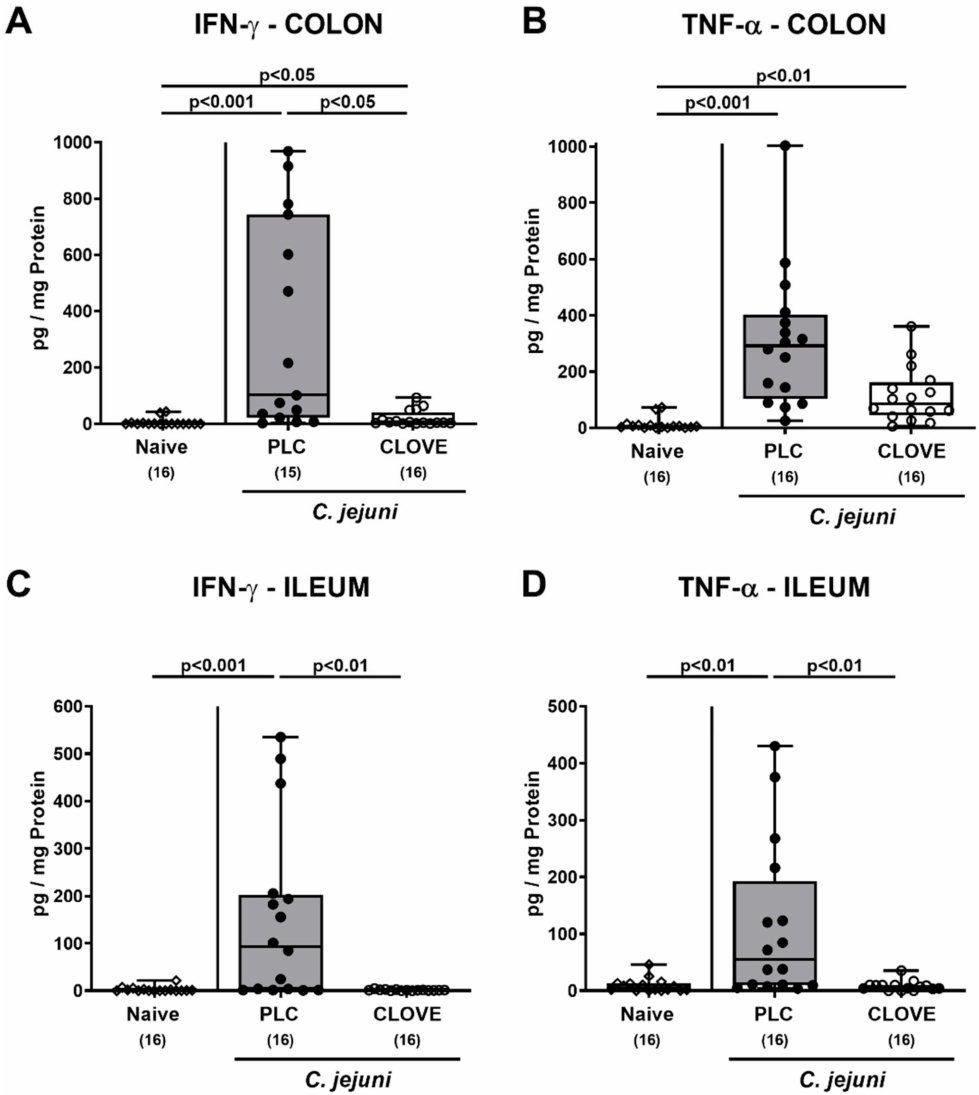
Figure 6. C. jejuni induced intestinal proinflammatory cytokine secretion following clove EO treat- ment of infected IL-10 − / − mice. Microbiota-depleted IL-10 − / − mice were perorally infected with C. jejuni strain 81-176 on day (d) 0 and d1. From d2 until d6 post-infection (p.i.), mice were perorally challenged with clove EO or received placebo (PLC) via drinking water. On day 6 p.i., ( A , C ) IFN- γ and ( B , D ) TNF- α concentrations were measured were measured in ex vivo biopsies derived from the ( A , B ) colon and ( C , D ) ileum. Box plots indicate the 75th and the 25th percentiles of the median (black bar within box). Naive mice were included as negative control animals. The total range, significance levels ( p values) determined by the Kruskal-Wallis test and Dunn’s post-correction and the total numbers of analyzed mice (in parentheses) are given. Data were pooled from four independent